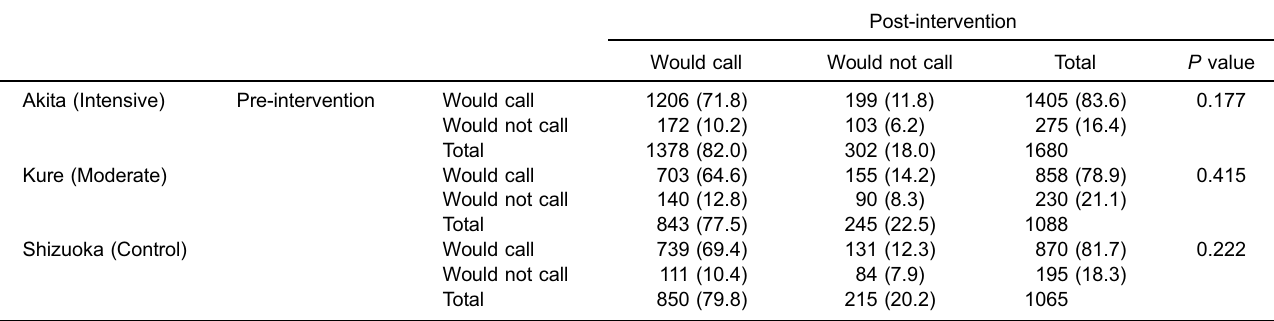
Table 3. Change in the proportion of the respondents who would call an ambulance at stroke onset